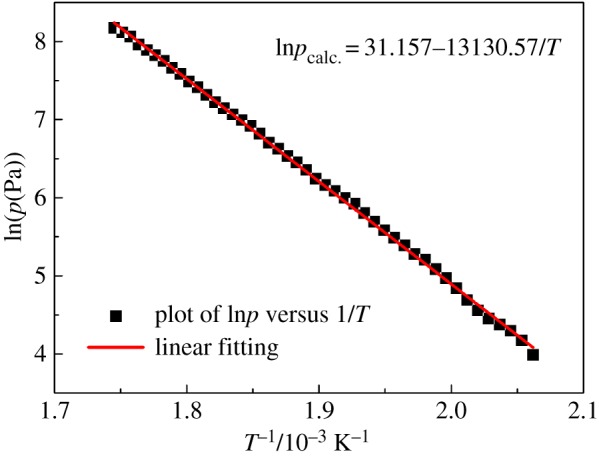
Plot of lnp versus 1/T for hafnium isopropoxide.